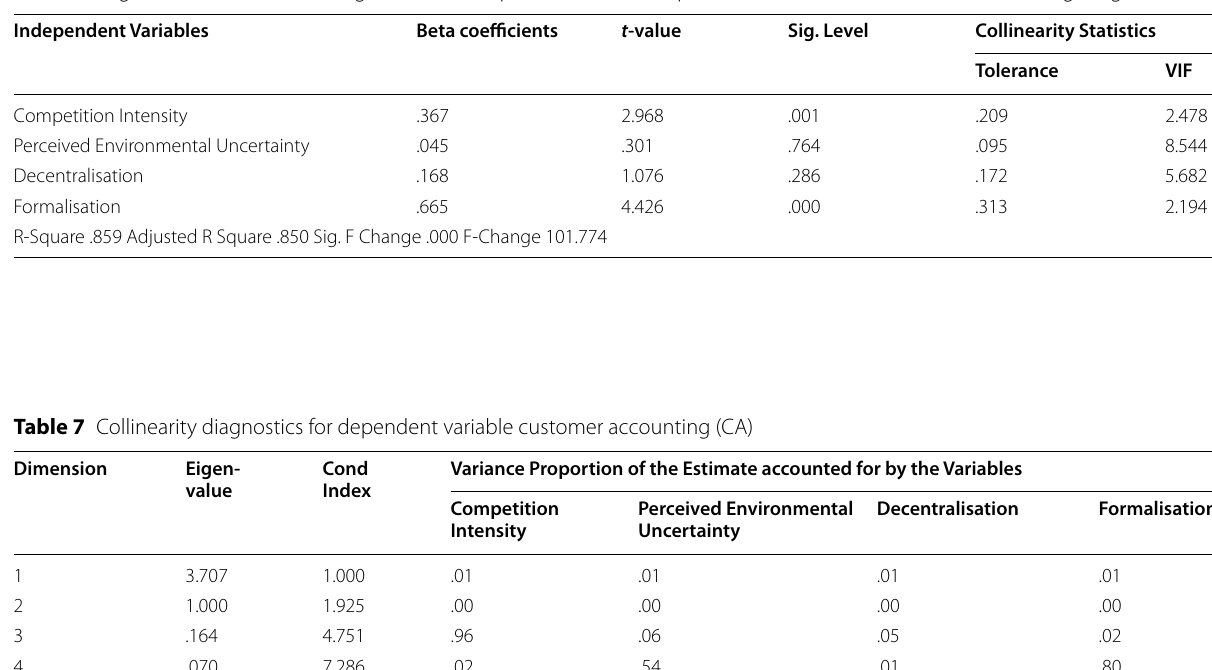
Table 6 Regression estimates showing the relationship between the independent variables and customer accounting usage ( n